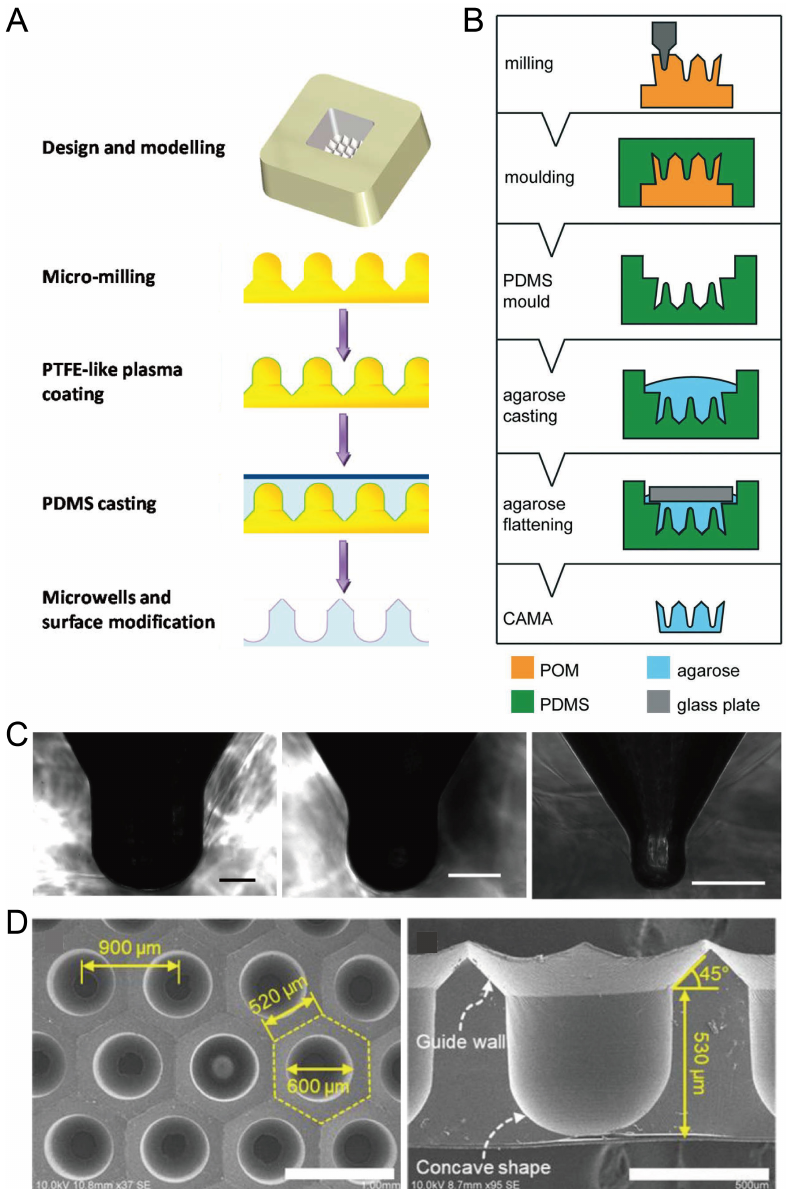
Figure 10. Fabrication of concave microwells by milling. ( A ) Firstly, a metallic mold was fabricated by precise CNC micromachining, and its surface was coated with polytetrafluoroethylene (PTFE)-like plasma. After that, the metallic mold was used for PDMS soft lithography to obtain the concave microwells [78]. ( B ) At first, a POM mold was prepared by CNC micromachining, and then used for double replica moldings of PDMS and agarose, respectively [81]. Reprinted (adapted) from [81]. Copyright (2018) with permission from Royal Society of Chemistry. ( C ) Pictures of a cross-section of concave microwells fabricated by the method illustrated in (A) [78]. Scale bars: 200 µm. Reprinted (adapted) from [78]. Copyright (2014) with permission from American Chemical Society. ( D ) Pictures of concave microwells fabricated by a similar method as that described in ( B ) [82]. The scale bar in the left picture shows 1 mm, and scale bar in the right picture shows 500 µm. Reprinted